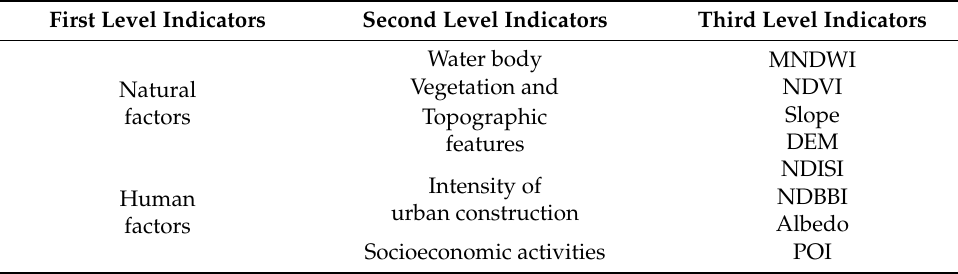
Table 5. Influencing factors of urban thermal